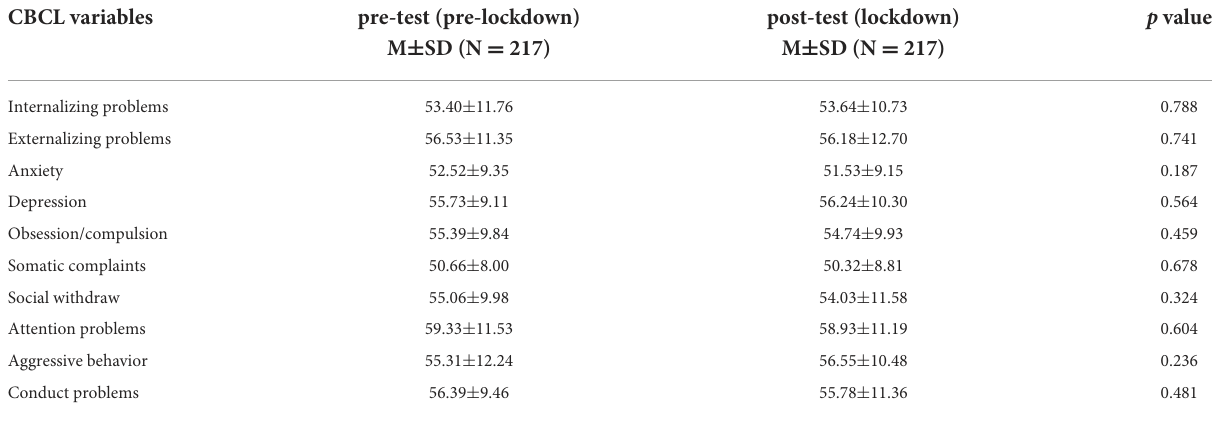
TABLE 2A Comparison of CBCL during the lockdown and pre-lockdown periods. CBCL